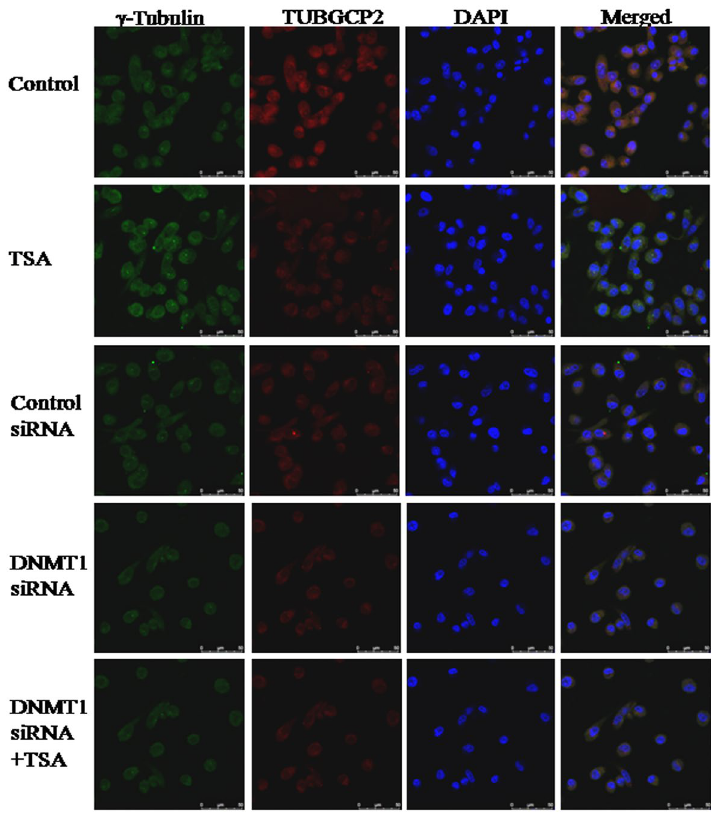
Figure 6. Immunofluorescent staining and confocal microscopy showing colocalizations of γ-tubulin and TUBGCP2 complexes in mitotic cells, which implicate knockdown of DNMT1 and specific inhibition of HDAC1 & HDAC2 synergistically, inhibit mitosis by reducing physical association of γ-tubulin with TUBGCP2, thereby inhibiting formation of γ-tubulin small complex (γTuSC). Ultimately, microtubule nucleation does not occur to form mitotic spindle for which less number of mitotic cells were